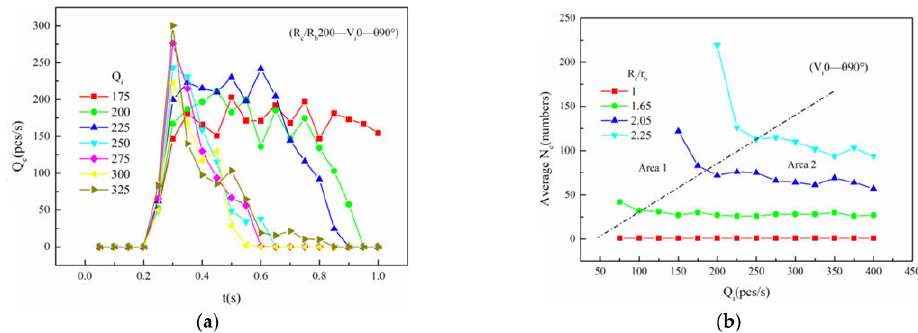
Figure 11. The effect of Q i on bridging results. ( a ) The the cumulative time from in a sparse flow to in a jammed flow. ( b ) The relationship between the average Nc and the Qi under different Rc/rb conditions.